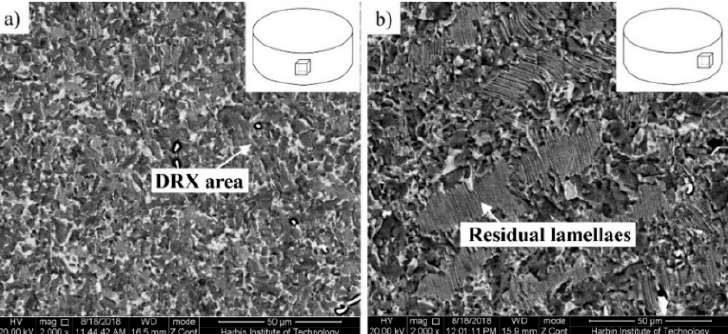
Figure 3. Microstructures of Ti-43Al-2Cr-1.5Mn-0.2Y alloy fabricated by SDF with a reduction of 60%. ( a ) Center area, ( b ) Bulging area.